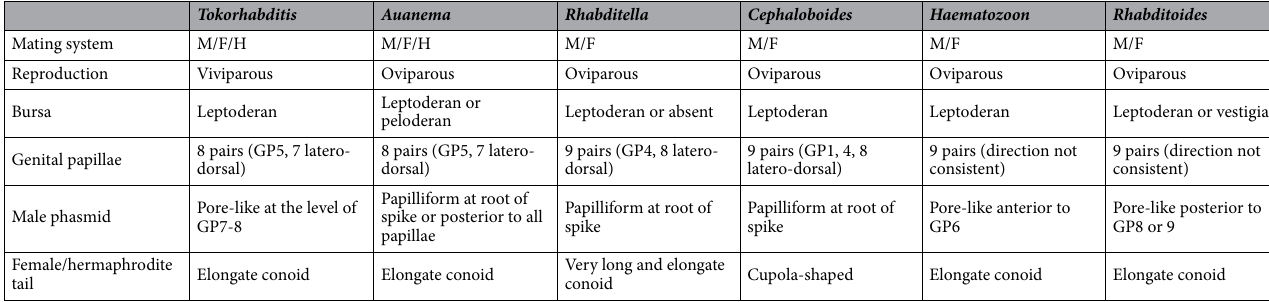
Table 1. Comparison of key typological characters among four closely related